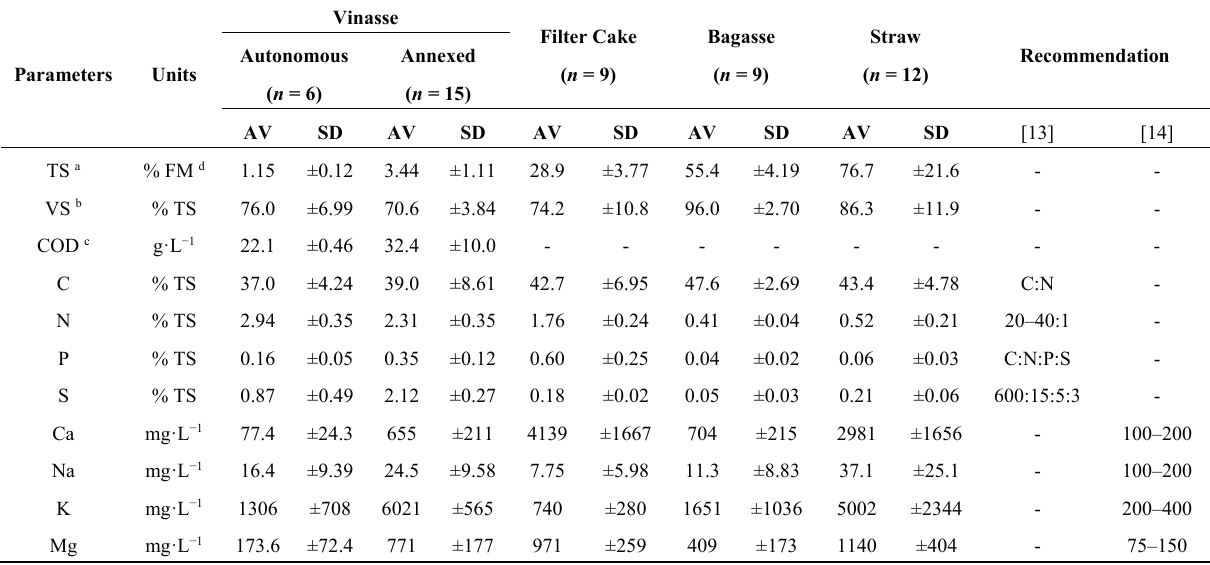
Table 1. Main characteristics of the sugarcane